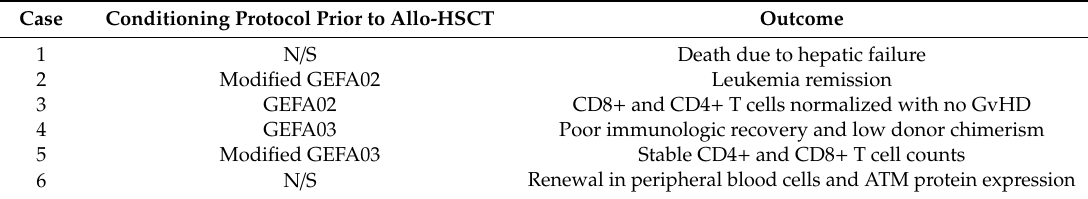
Table 2. Summary of bone marrow transplantation in A-T